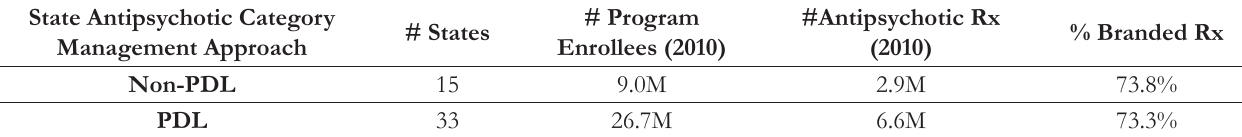
Table 2. Descriptive Statistics, by State Medicaid Antipsychotic Category Management Approach State Antipsychotic Category